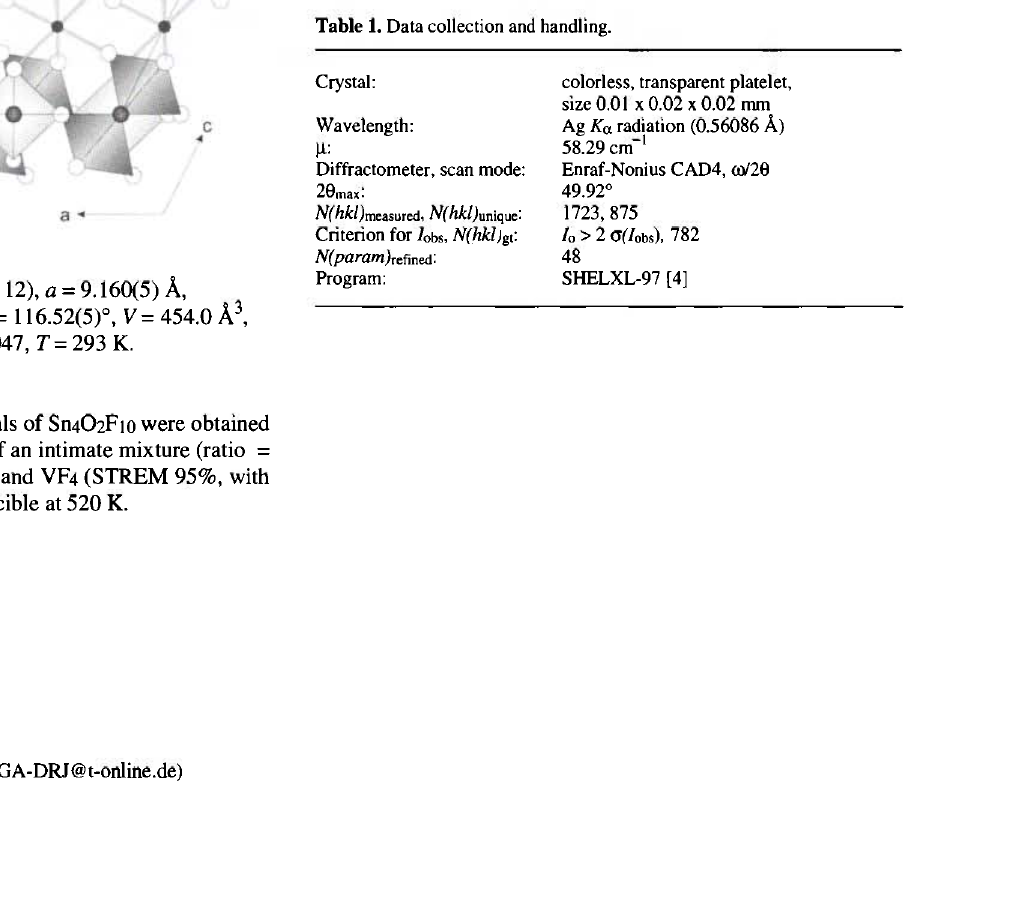
Table 1. Data collection and